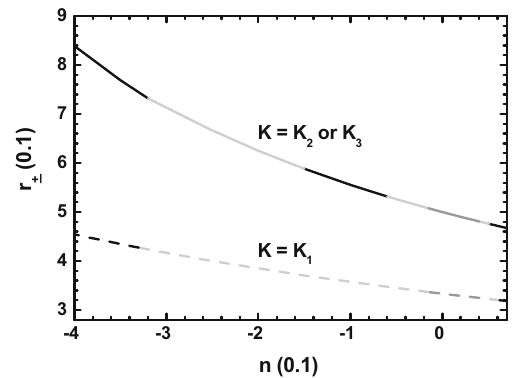
Fig. 3 Values of r ± allowed by Eq. (20) as a function of n for K = K 1 (dashedlines)and K = K 2 or K 3 (solidlines).Thevalueswhicharealso preferred by the observational data at 68% c.l. [95% c.l.] are included in the dark [light] gray segments